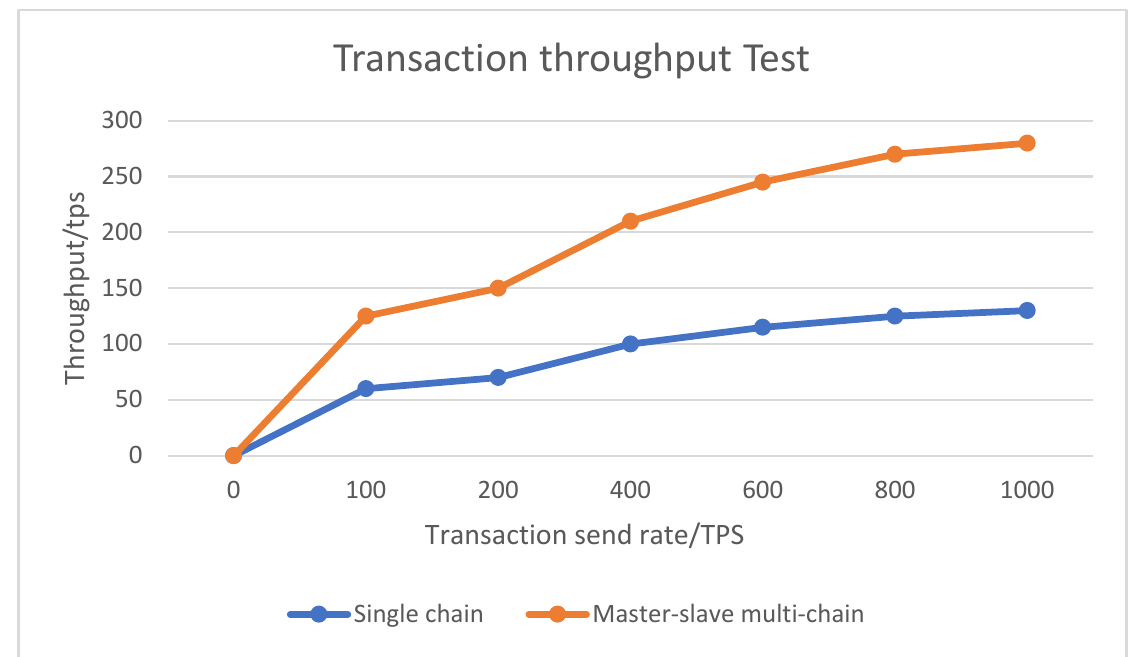
Figure 13. Single-chain and master–slave multi-chain transaction throughput test chart.